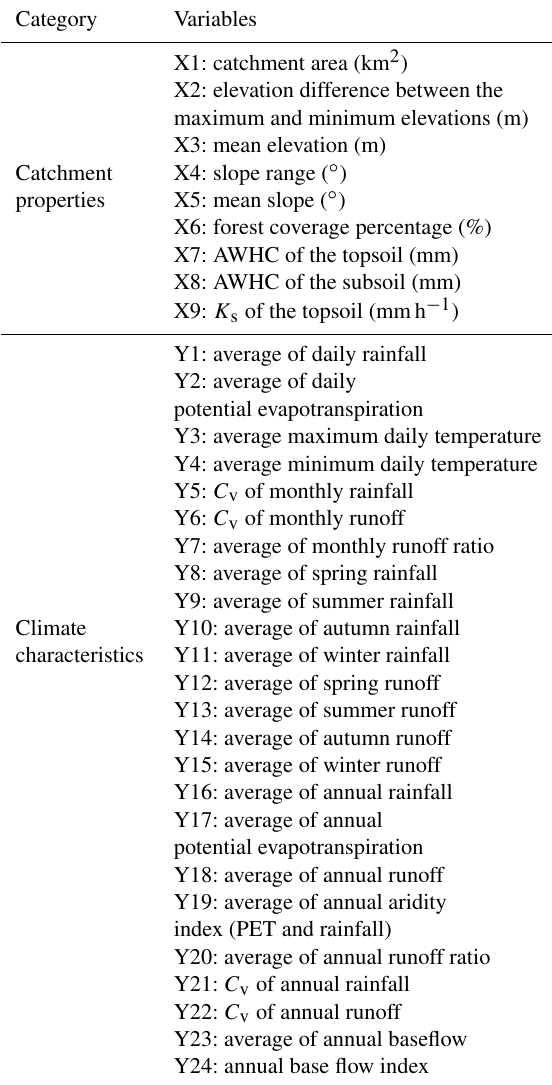
Table 2. Potential factors for exploring the association between the change of the CWSC with catchment properties and climate char-